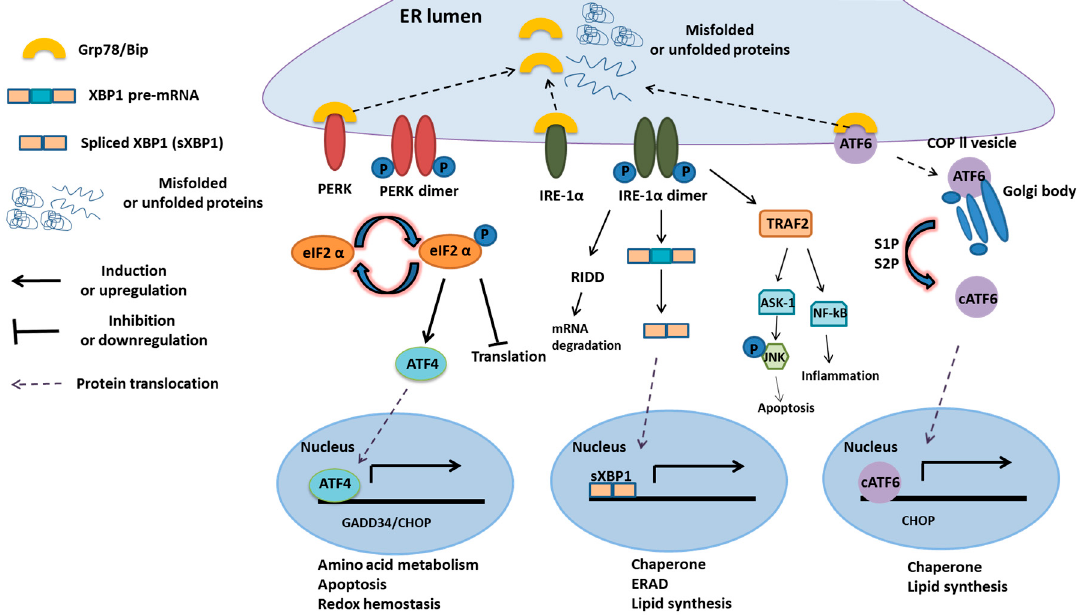
Figure 1. Overview of the UPR process [14]. Upon stimulation of the unfolded protein response, the Grp78 / Bip is recruited as a chaperone and leaves its interaction with the three transmembrane proteins of the unfolded protein response (UPR), the IRE-1 α , PERK, and ATF6. This allows these proteins to oligomerize and become activated PERK dimerizes and phosphorylates the eIF2 α suppressing 5’capped mRNA translation.